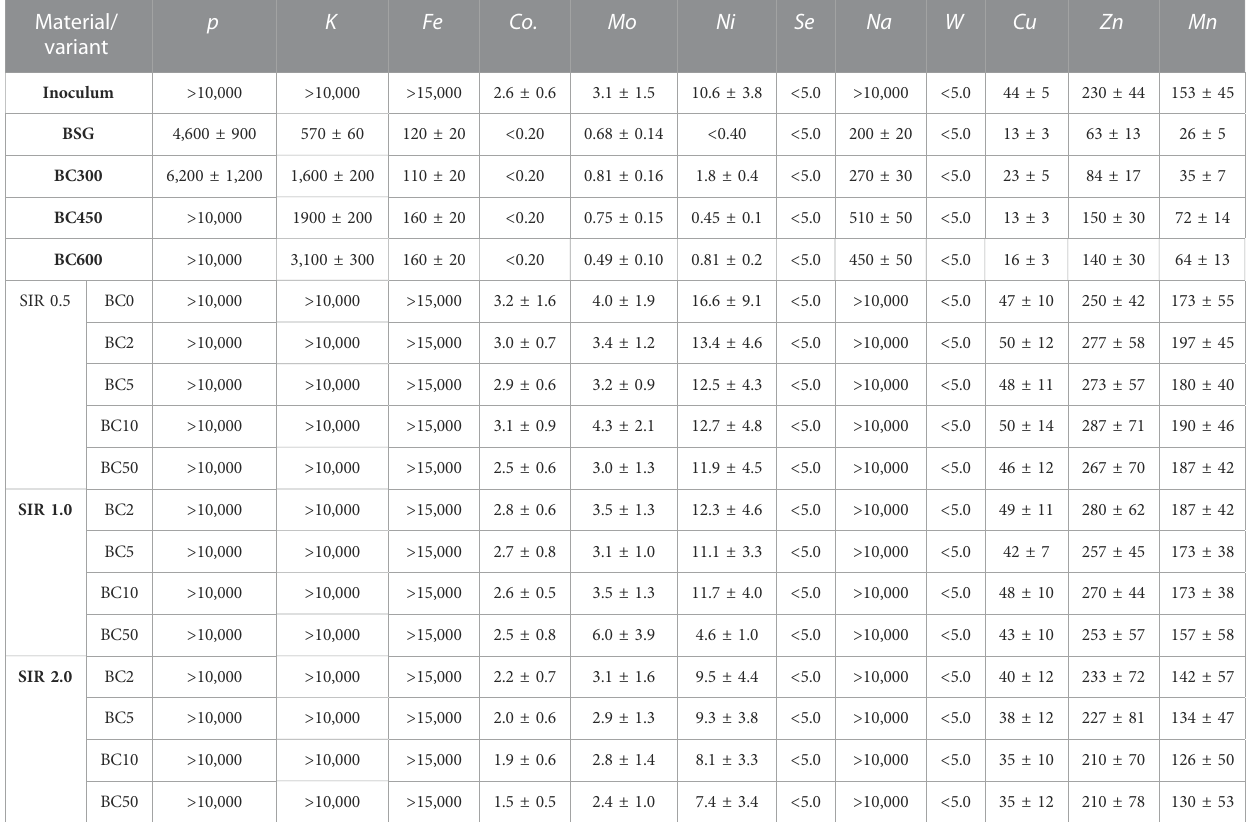
TABLE 3 Macro- and micronutrients and trace elements in substrate and process residues, values are given in mg×kg − 1 as a dry basis. Material/